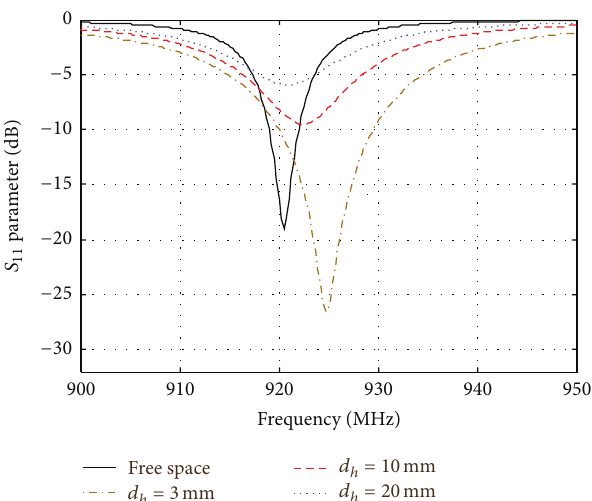
Figure 8: Simulated antenna (with silver fabric) reflection coeffi- cient in free space and for various distances to the human body.